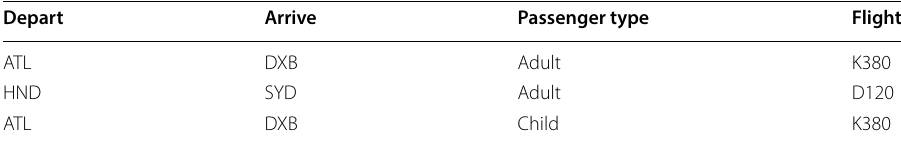
Table 4 Passenger’s records